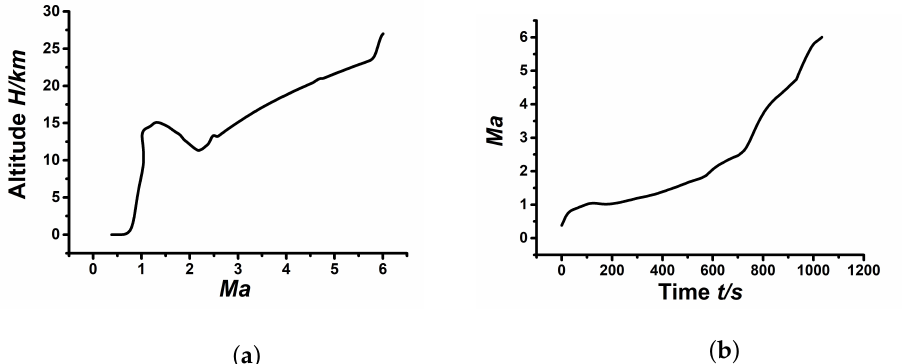
Figure 4. The flight trajectory of XTER: ( a ) Altitude vs. Mach number; ( b ) Mach number vs. time.